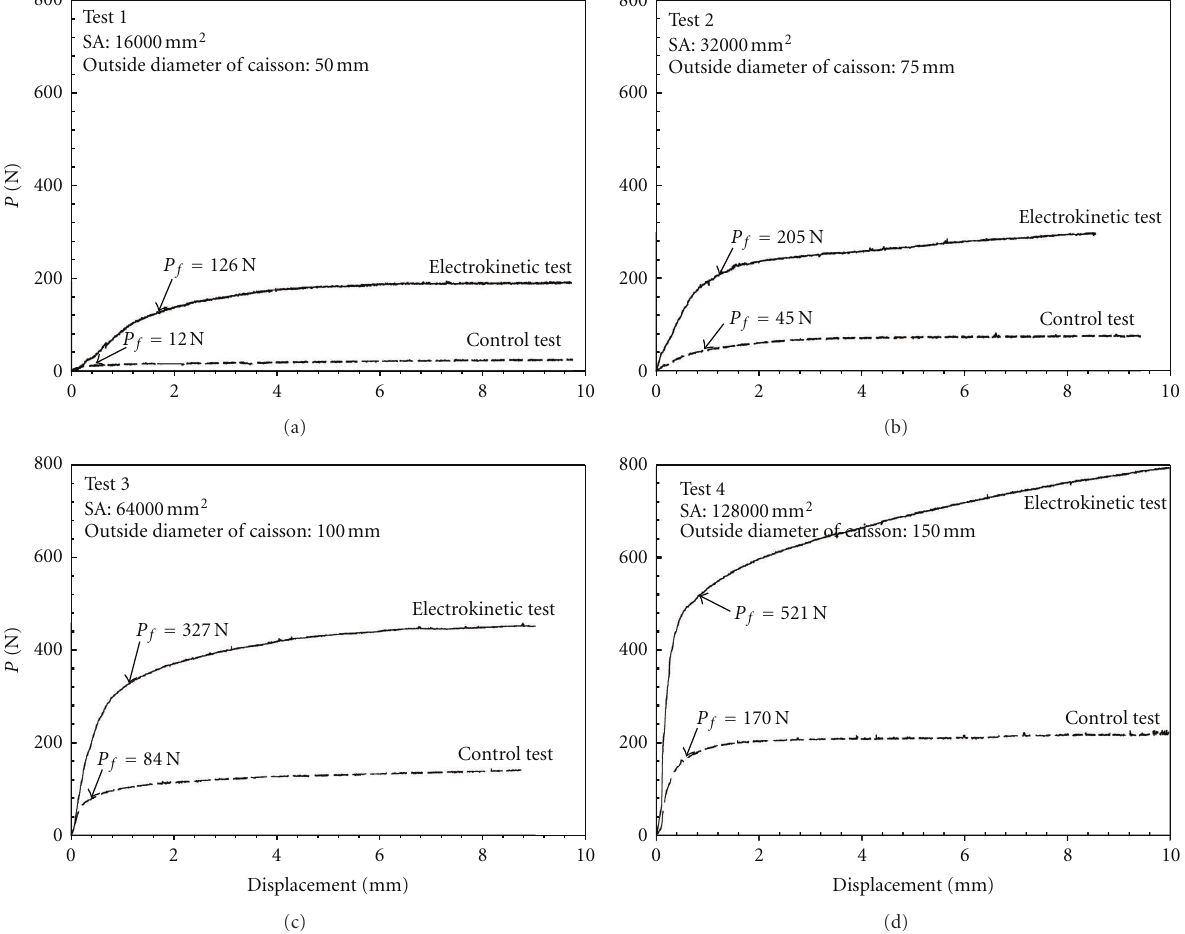
Figure 7: Axial load capacity, P , versus vertical displacement of the model caisson.